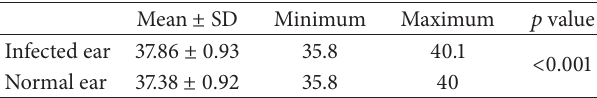
Table 1: Comparison of the temperatures ( ∘ C) of infected ear and the normal ear in patients with acute otitis